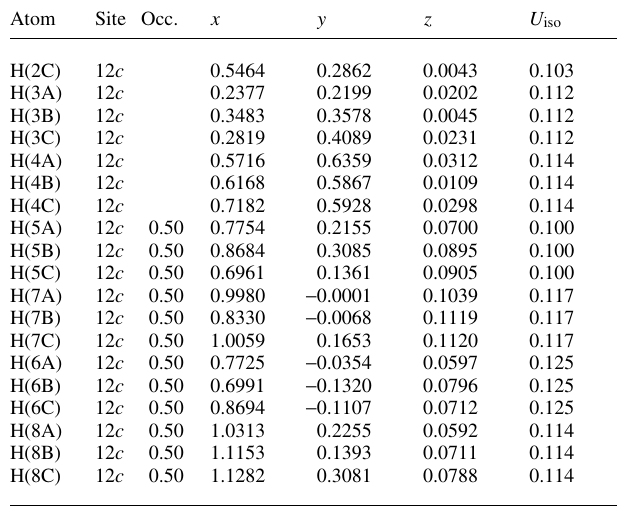
Table 3. Atomic coordinates and displacement parameters (in Å 2 ) .